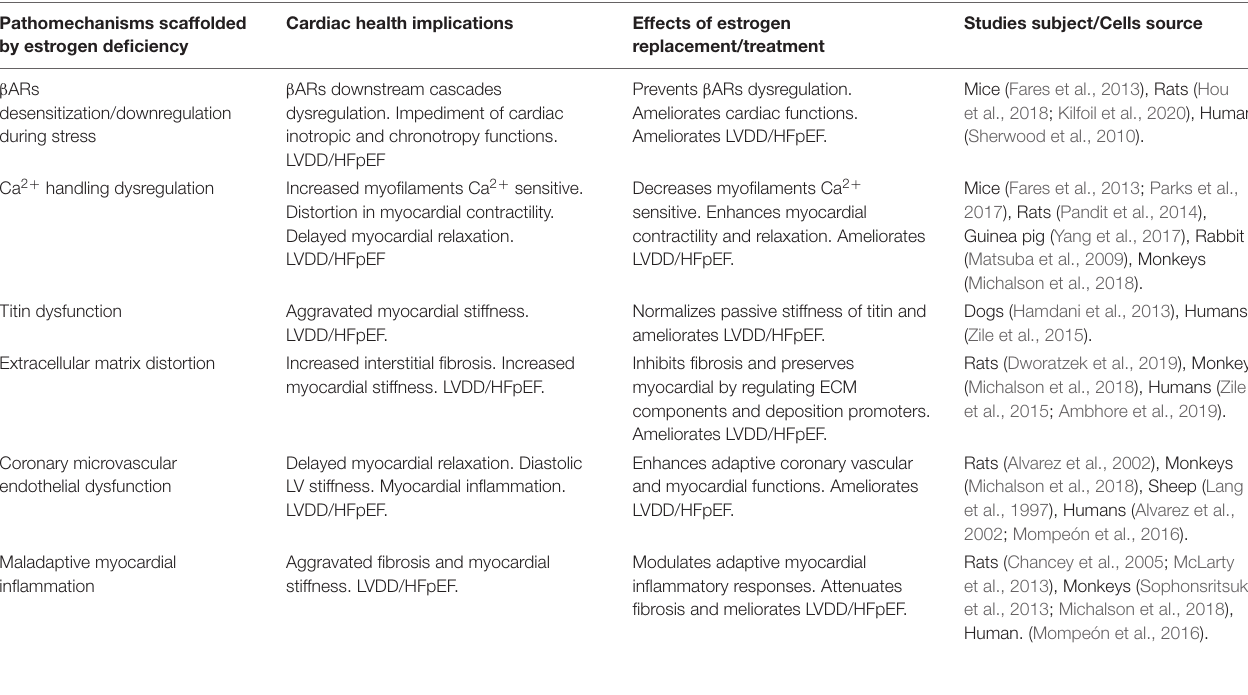
TABLE 1 | Overview of HFpEF underlying pathomechanisms scaffolded by estrogen deficiency and the ameliorative effects of estrogen